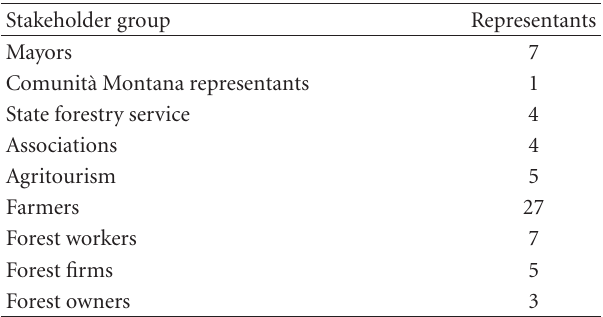
Table 1: Stakeholder